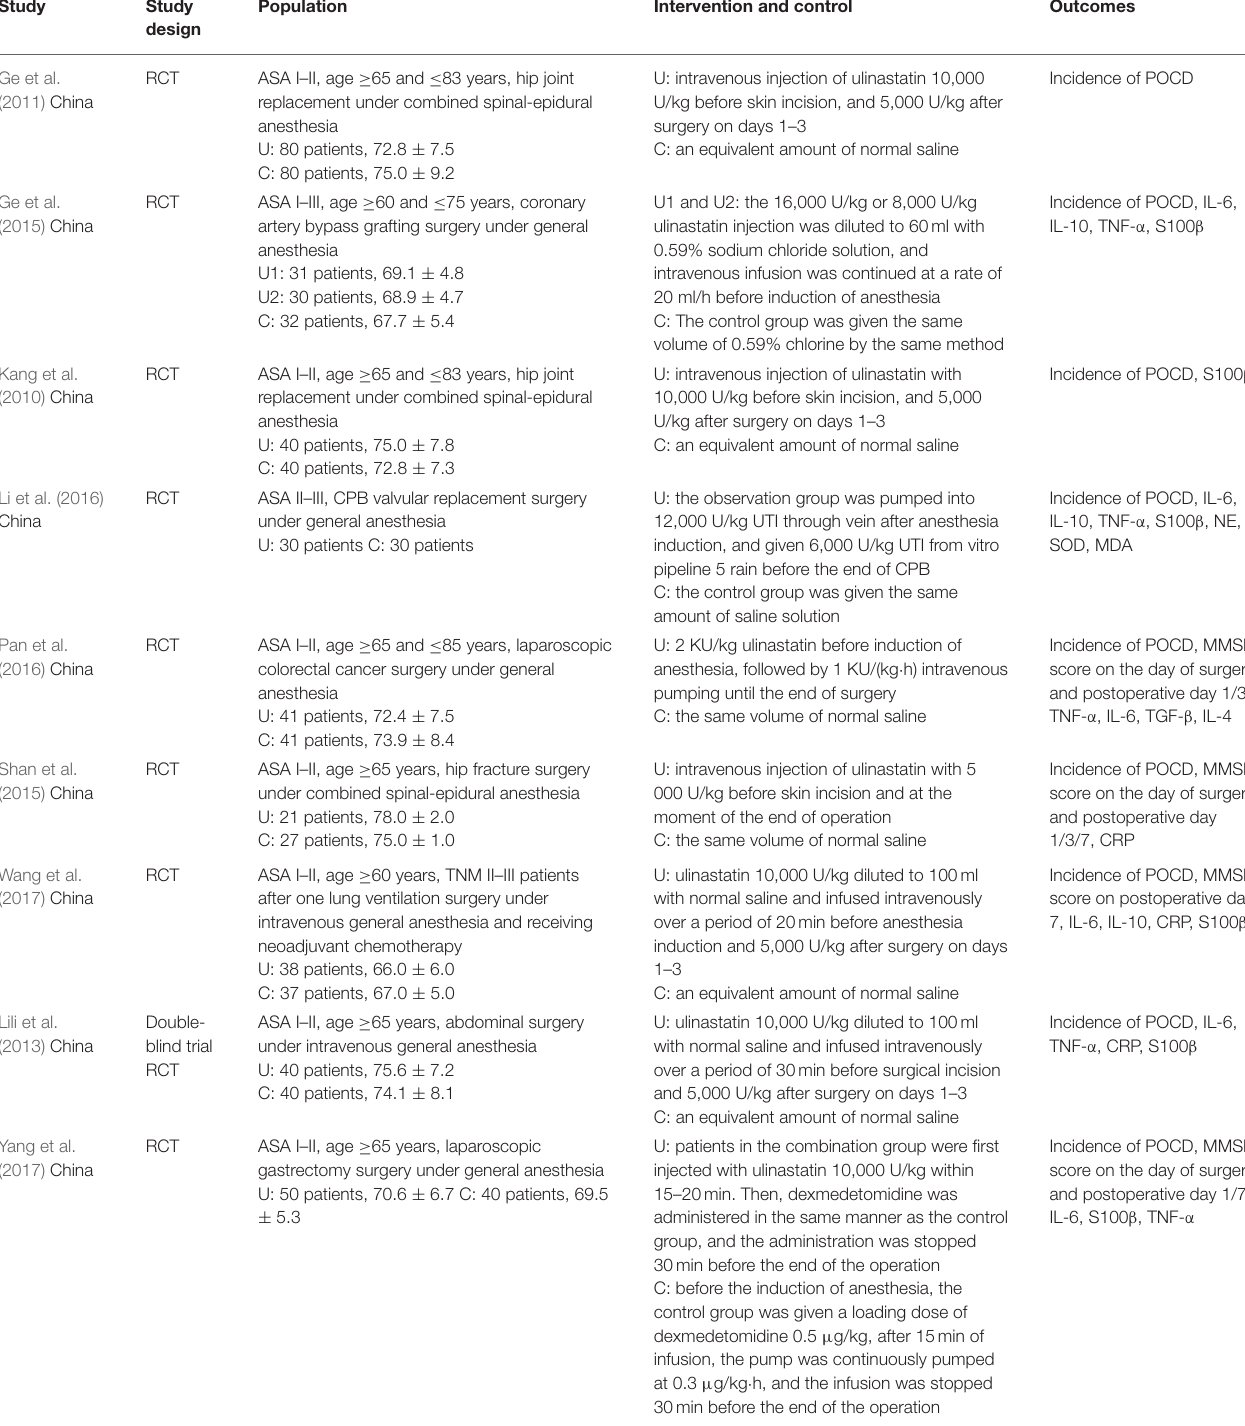
TABLE 1 | Characteristic of the included